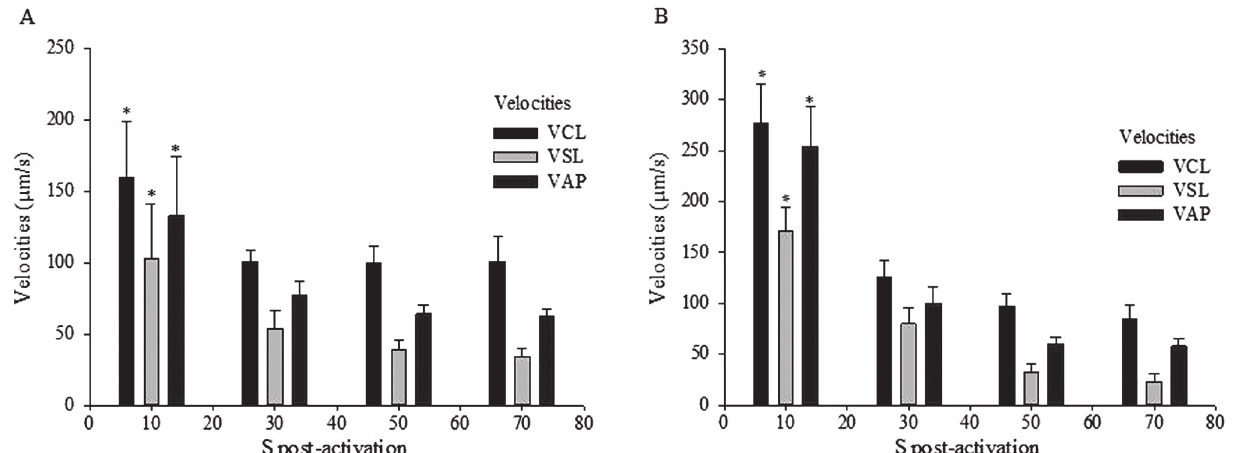
Fig. 2. Post-thaw sperm velocities (curvilinear = VCL; straight-line = VSL; average path = VAP) of Brycon orbignyanus (A; n = 18 males) and Prochilodus lineatus (B; n = 21 males) evaluated after 10, 30, 50 and 70s after activation. * Mean at 10s was the highest (Scott-Knott, P <